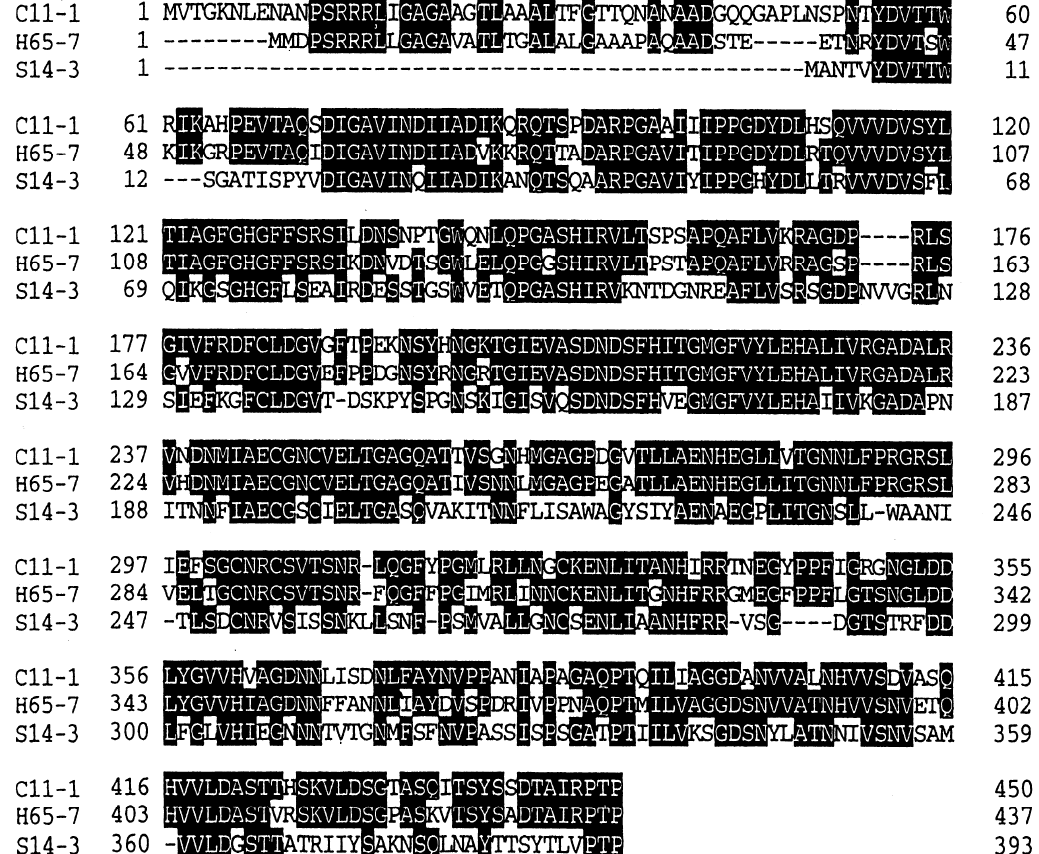
Figure 2. The comparison of deduced amino acid sequences of inulin